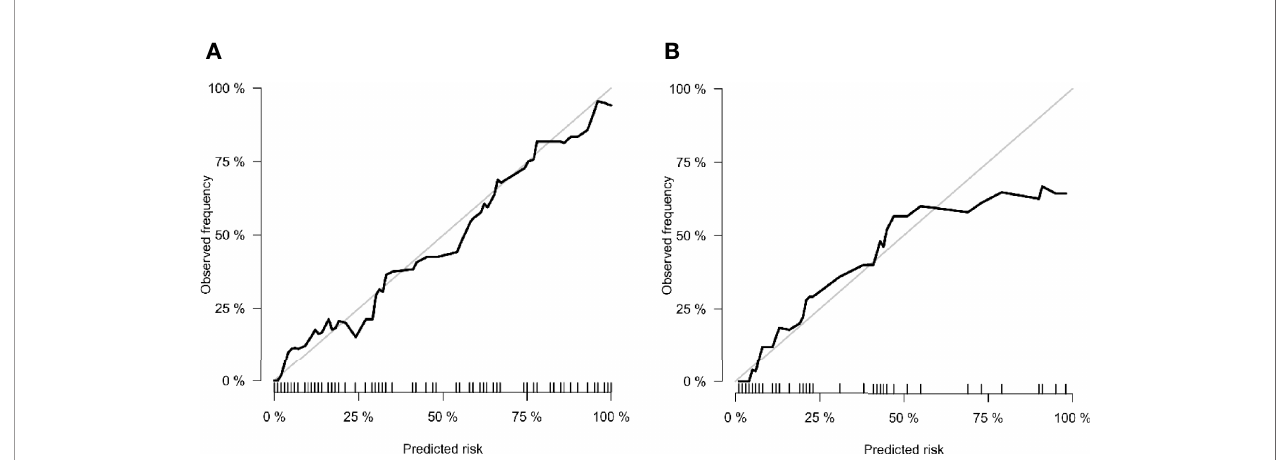
FIGURE 7 | Calibration curves of (A) training cohort and (B) validation cohort. The x-axis is the nomogram-predicted probability. The y-axis is the observed probability. The closer fi t of the diagonal curved line to the ideal straight line indicates the predictive accuracy of the nomogram from the best model.